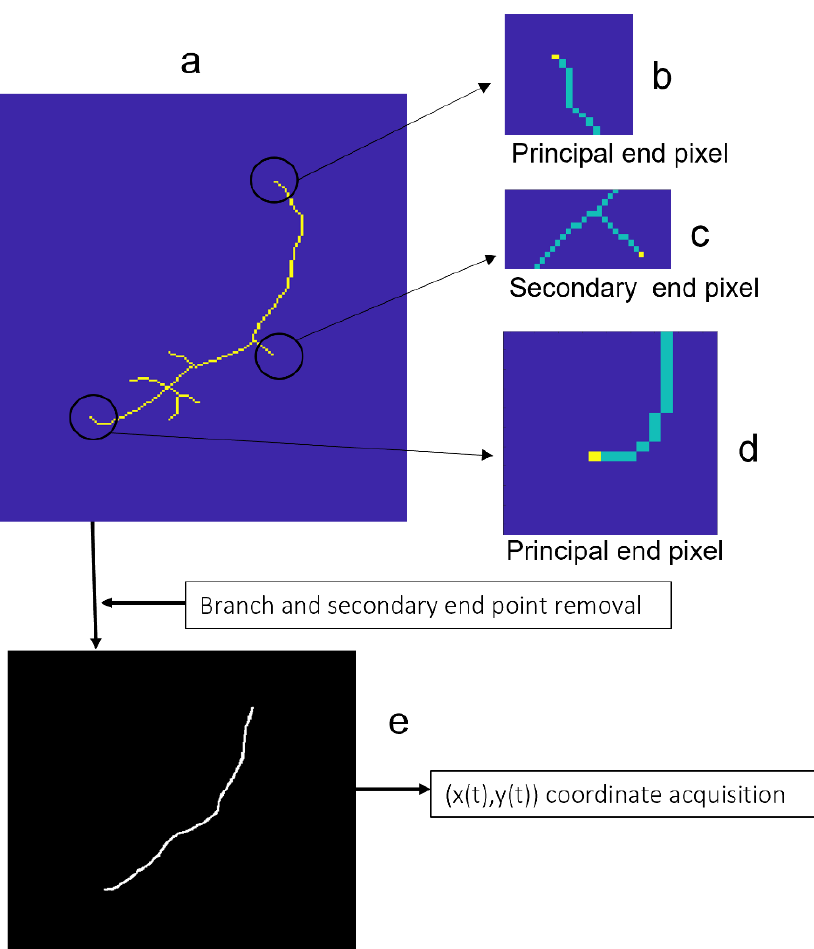
Figure 5. Vessel segment refinement, coordinate acquisition, and parametrization. ( a ) Skeletonized element; Endpoints: principal ( b , d ), secondary ( c ); ( e ) 1-pixel wide curve of connected pixels running along the central line of the vessel segment for coordinate